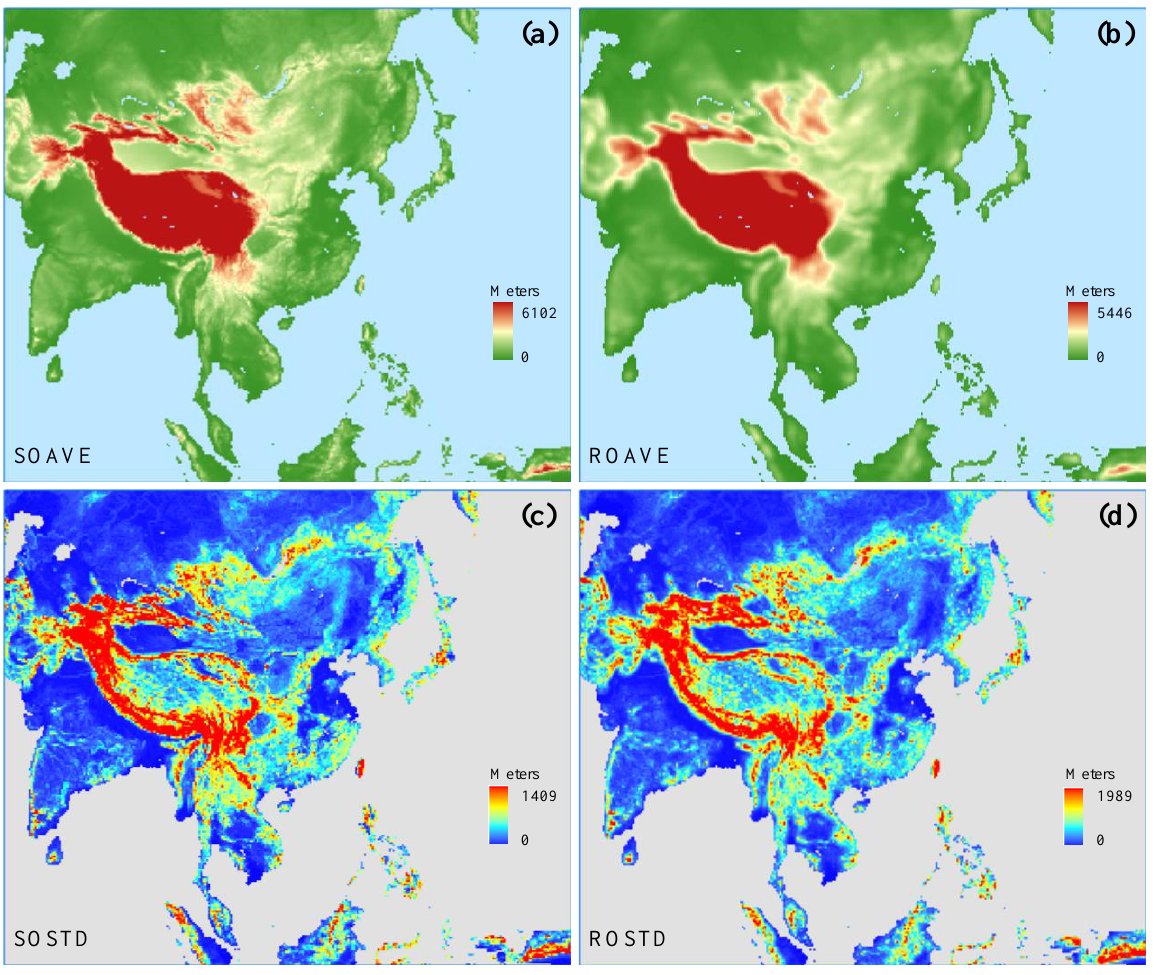
Figure 2. The comparison of geographic distributions of surface orography parameters over the Asia RCM domain. (a) and (b) denote mean terrain elevations at subgrid-scale and resolved-scale, respectively; (c) and (d) denote standard deviations of terrain elevations at subgrid-scale and resolved-scale,